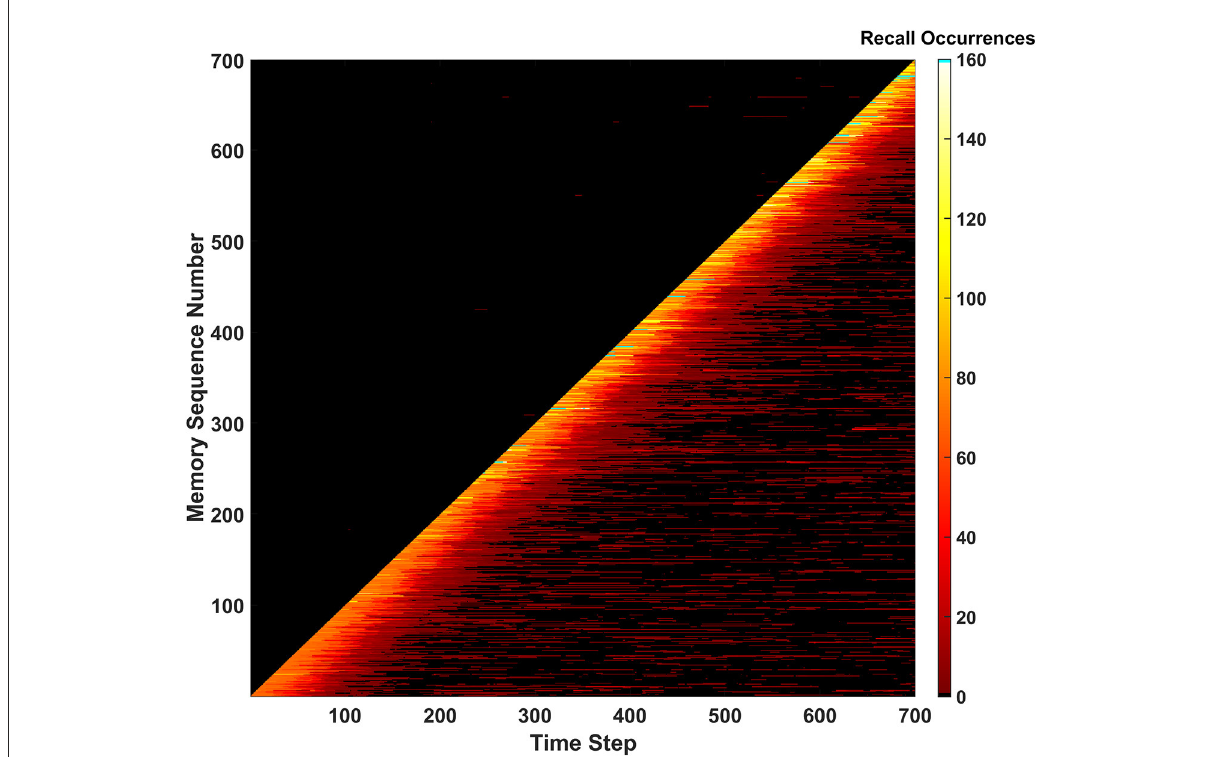
FIGURE10 Recall occurrences heatmap for the forgetting behavior. Memories can be seen being forgotten as time progresses, and then remembered during intermittent periods for the remainder of the simulation (due to similar memories to the ones forgotten being newly introduced to the